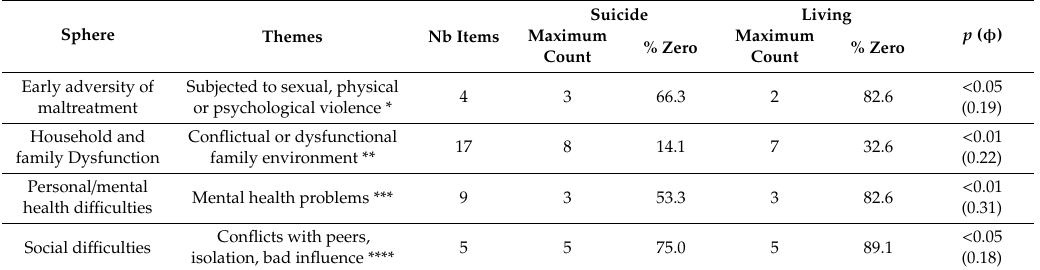
Table 3. Number of variables present for each sphere: comparison between groups.